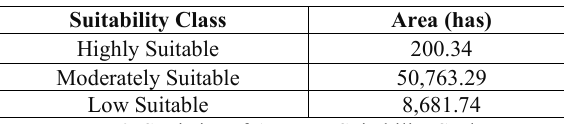
Table 3 . Statistics of Area per Suitability